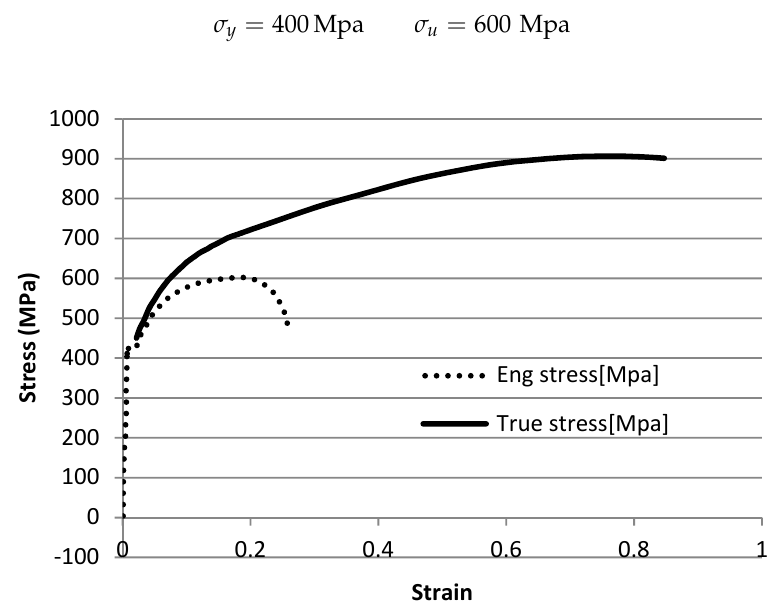
Figure 2. The true and engineering stress-strain curves.